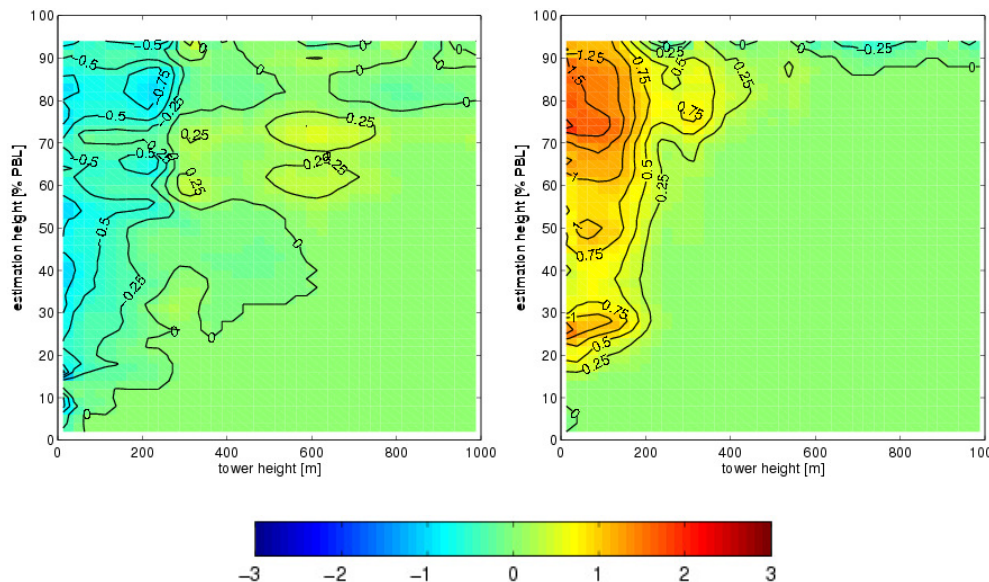
Figure 4. The median bias between the true CO 2 mole fraction and the estimated one using the VTT concept as a function of the height of the hypothetical tower (tower height) simulated by the aircraft or the existing tower and the relative height within the PBL for which the mole fraction is extrapolated (estimation height) from the measurements at the top of the hypothetical tower (µmolmol − 1 ) . A negative sign means underestimation by the measurements. Left: summer; right: